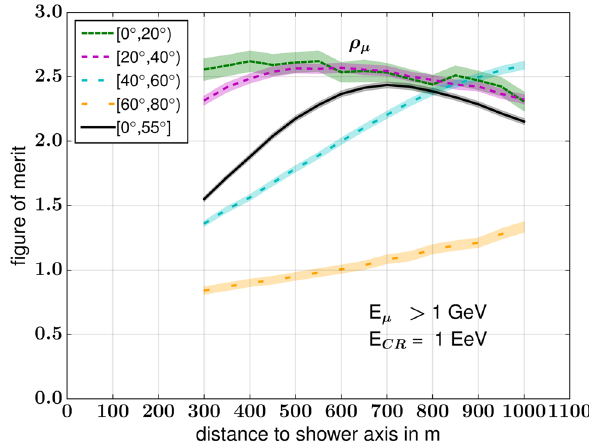
Fig. 4 Figure of merit compared to the distance to the shower axis for different zenith angle ranges and for combining showers at all zenith angles. The muon density is normalized to a primary energy of 10 18 eV for all showers. The figure of merit decreases with the zenith angle due to larger shower-to-shower fluctuations. It shows a maximum between 600–800 m for the range of 0 ◦ –55 ◦